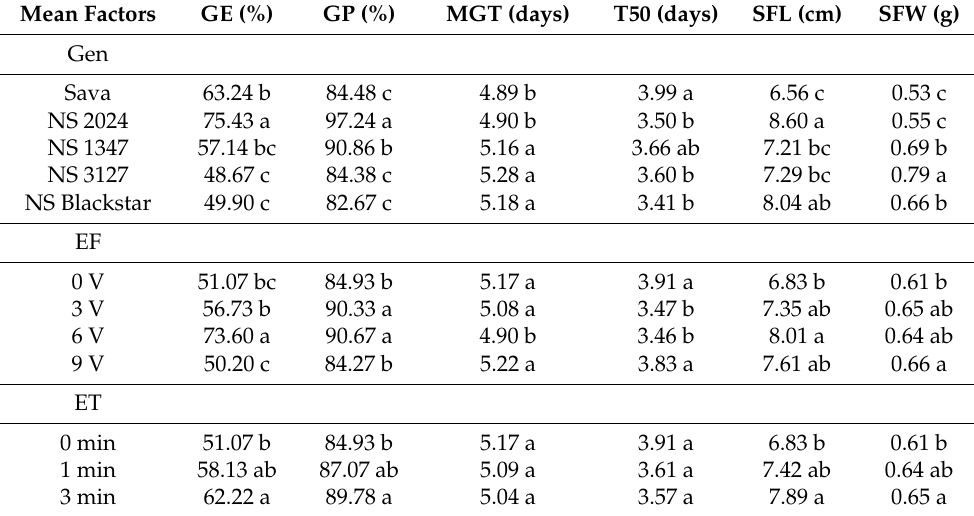
Within columns, means followed by the same letter are not different at the 0.05 level of probability using the LSD test. Gen: genotype; EF: electrostatic field; ET: exposure time.